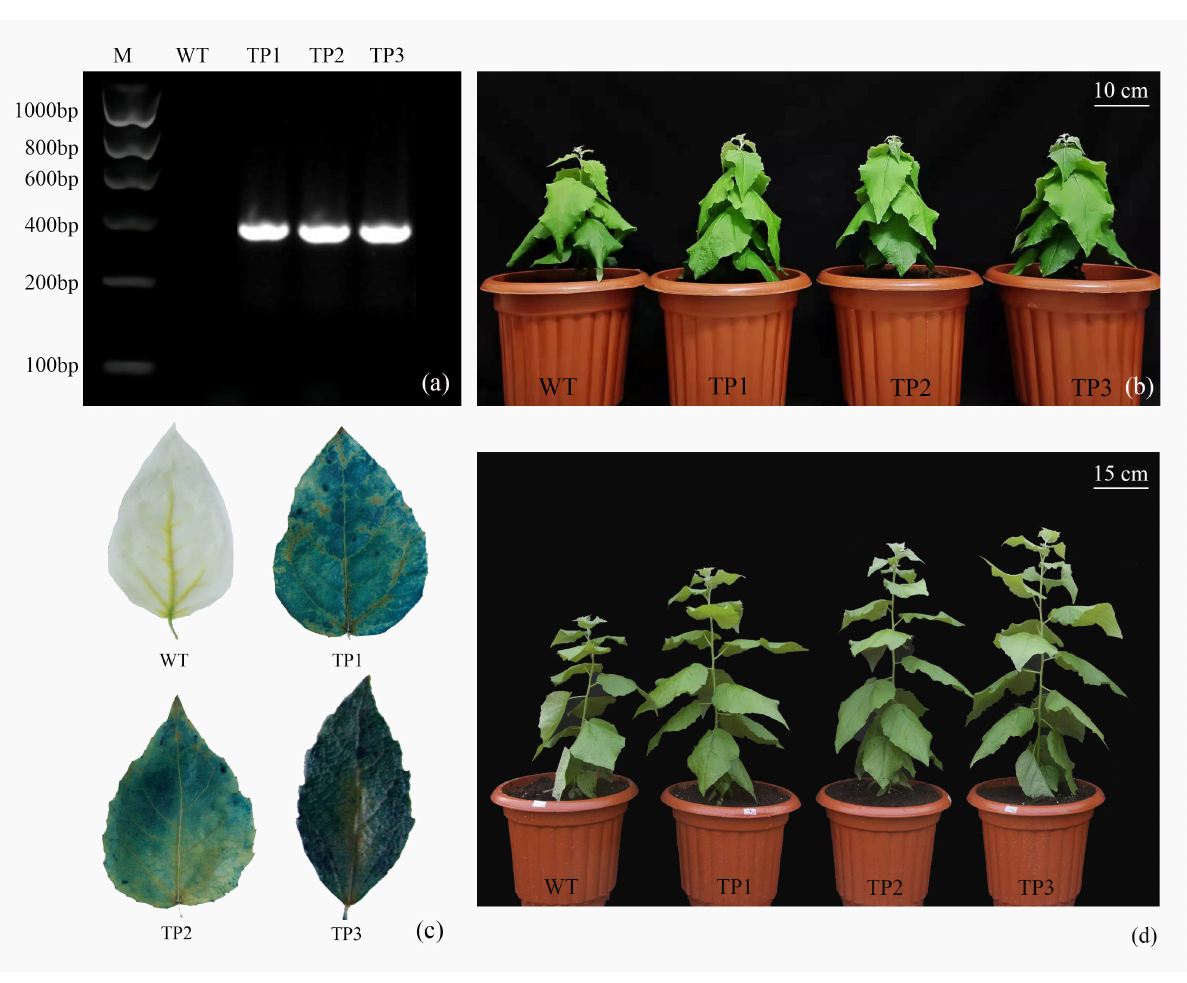
Figure 2. Molecular analyses of OsCYP85A1 transgenic trees. ( a ) PCR analysis of wild-type and different independently generated transgenic lines. ( b ) Phenotypes of wild-type and three independent OsCYP85A1 transgenic lines grown in a glass greenhouse for 7 weeks. ( c ) GUS staining of OsCYP85A1 transgenic plants. ( d ) The 70 d transgenic plants.